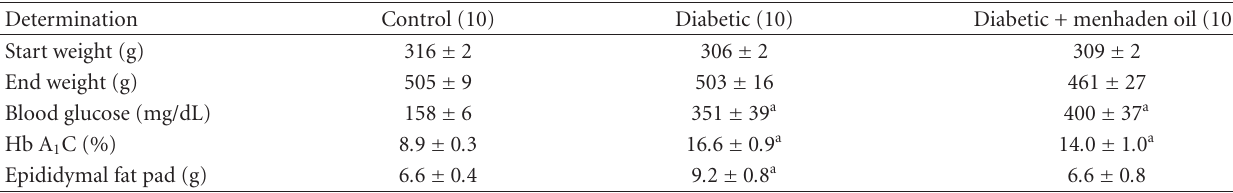
Table 3: E ff ect of partial menhaden oil substitution in the diet of high-fat/streptozotocin diabetic rats on change in body weight, blood glucose, hemoglobin A 1 C, and epididymal fat pad.